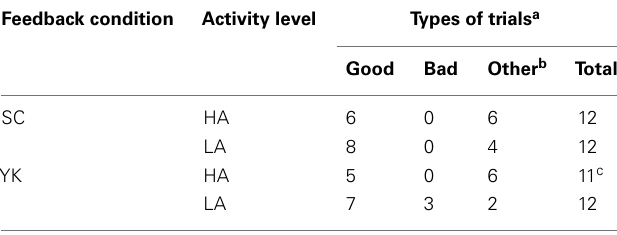
Table 1 | Number of responses for the Self-Control-HighActivity (SC-HA), Self-Control-LowActivity (SC-LA),Yoked-HighActivity (YK-HA), andYoked-LowActivity (YK-LA) groups indicating when they asked for (SC) or would have preferred (YK) to receive